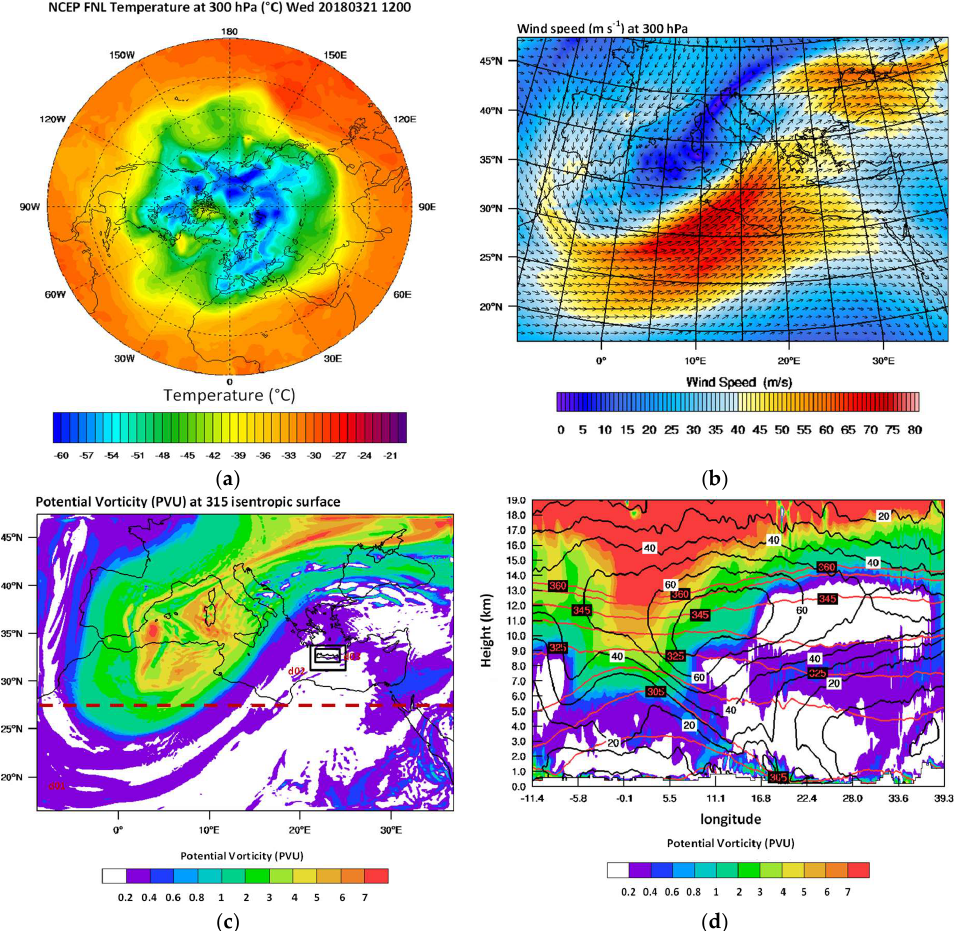
Atmosphere 2018 , 9 , x FOR PEER REVIEW Figure 2. ( a ) Temperature at 300 hPa, 21 March 2018, 1200 UTC ( b ) Wind speed and vectors at 300 hPa, 22 March 0600 UTC ( c ) Potential Vorticity (PVU) at the 315 K isentropic surface, 22 March 0600 UTC and the three-domain structure (d01,d02,d03). The horizontal dashed line indicates the location of the vertical cross-section shown in ( d ); ( d ) Potential temperature (red contours every 15 K), wind speed (black contours every 10 ms −1 ) and Potential Vorticity (color scale in PVU), 22 March 0600 UTC.